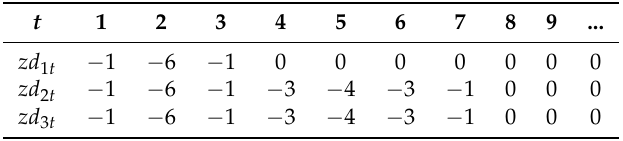
Table 5. Negative demand shocks in the asymmetric monetary